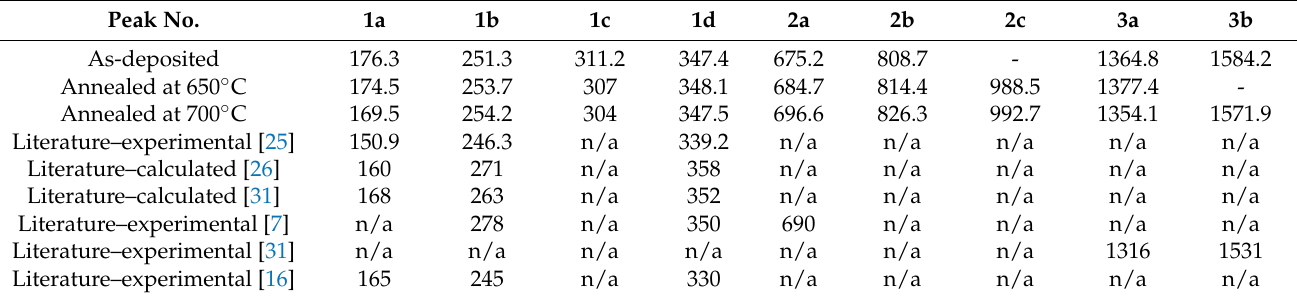
Table 1. Values of the Raman peaks resulted from the fitting of the experimental data, together with their